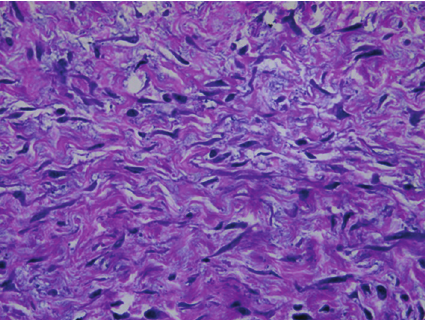
Figure 5: Fleshy cut section.